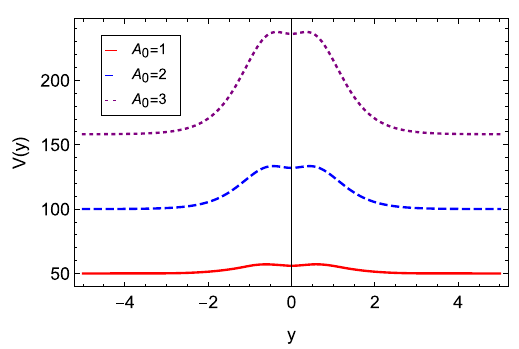
Fig. 6 Solutions for the matter potential U ( y ) from Sect. 3.4 with ϕ = 1, A = 1 and k = 1. The potential gets steeper with a decrease 0 0 in ψ 0